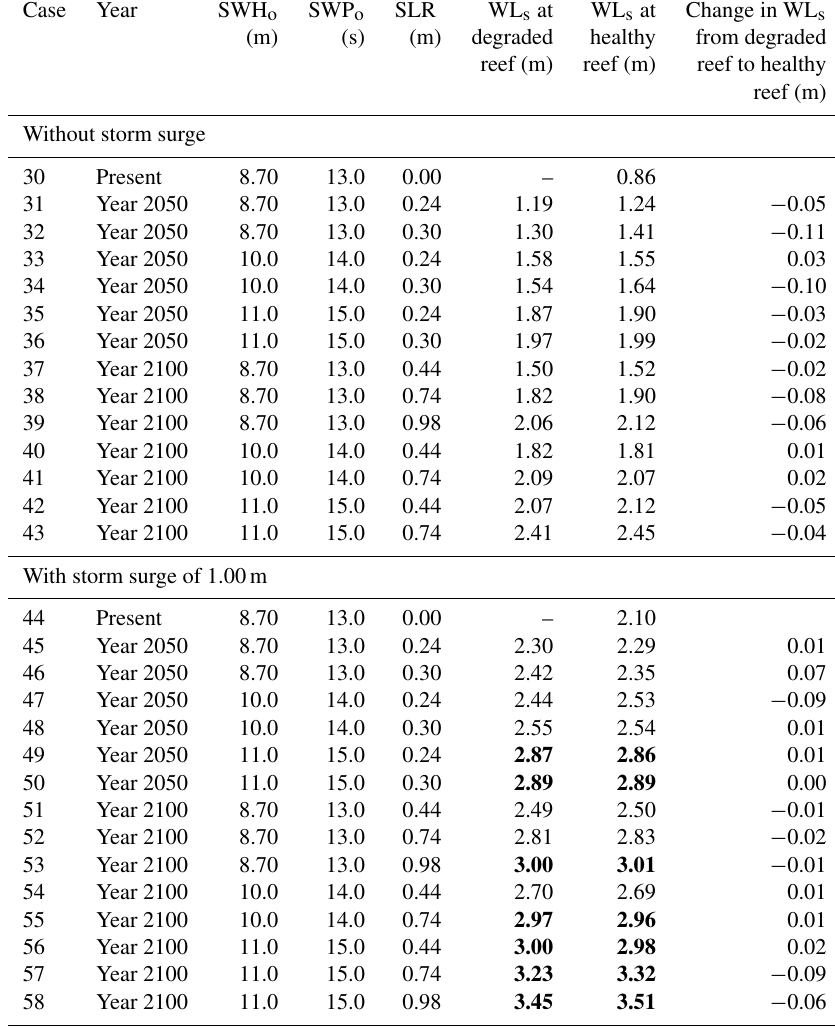
Table 4. Flooding risk at the study